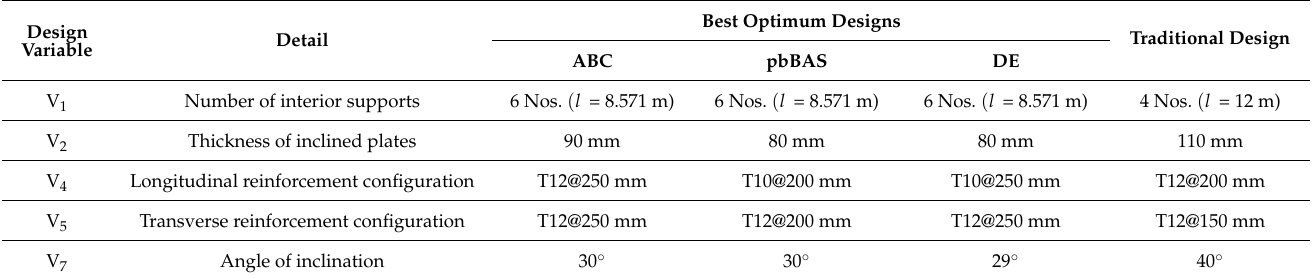
Table 15. The optimum values of folded plates variables obtained by each metaheuristic algorithm for the V-type folded plate roof building.